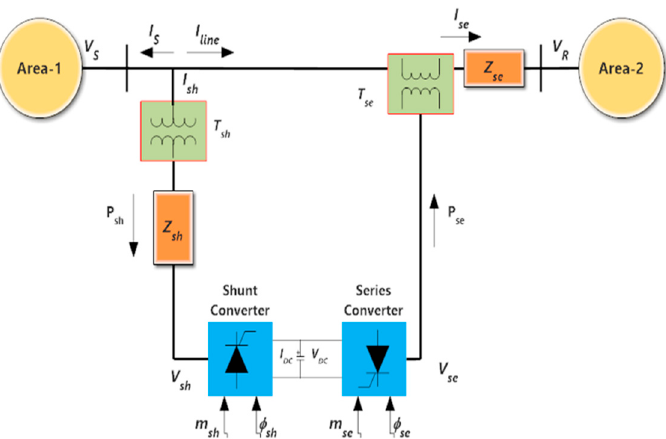
Figure 5. Model of UPFC integration in interlinked hydro systems.